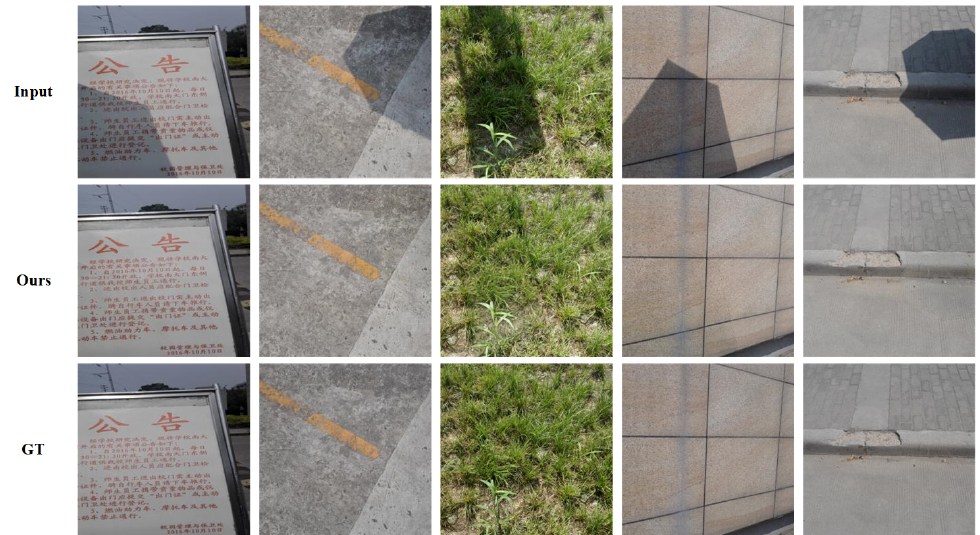
Figure 4. Shadow removal results of our proposed method on the scene images from ISTD dataset